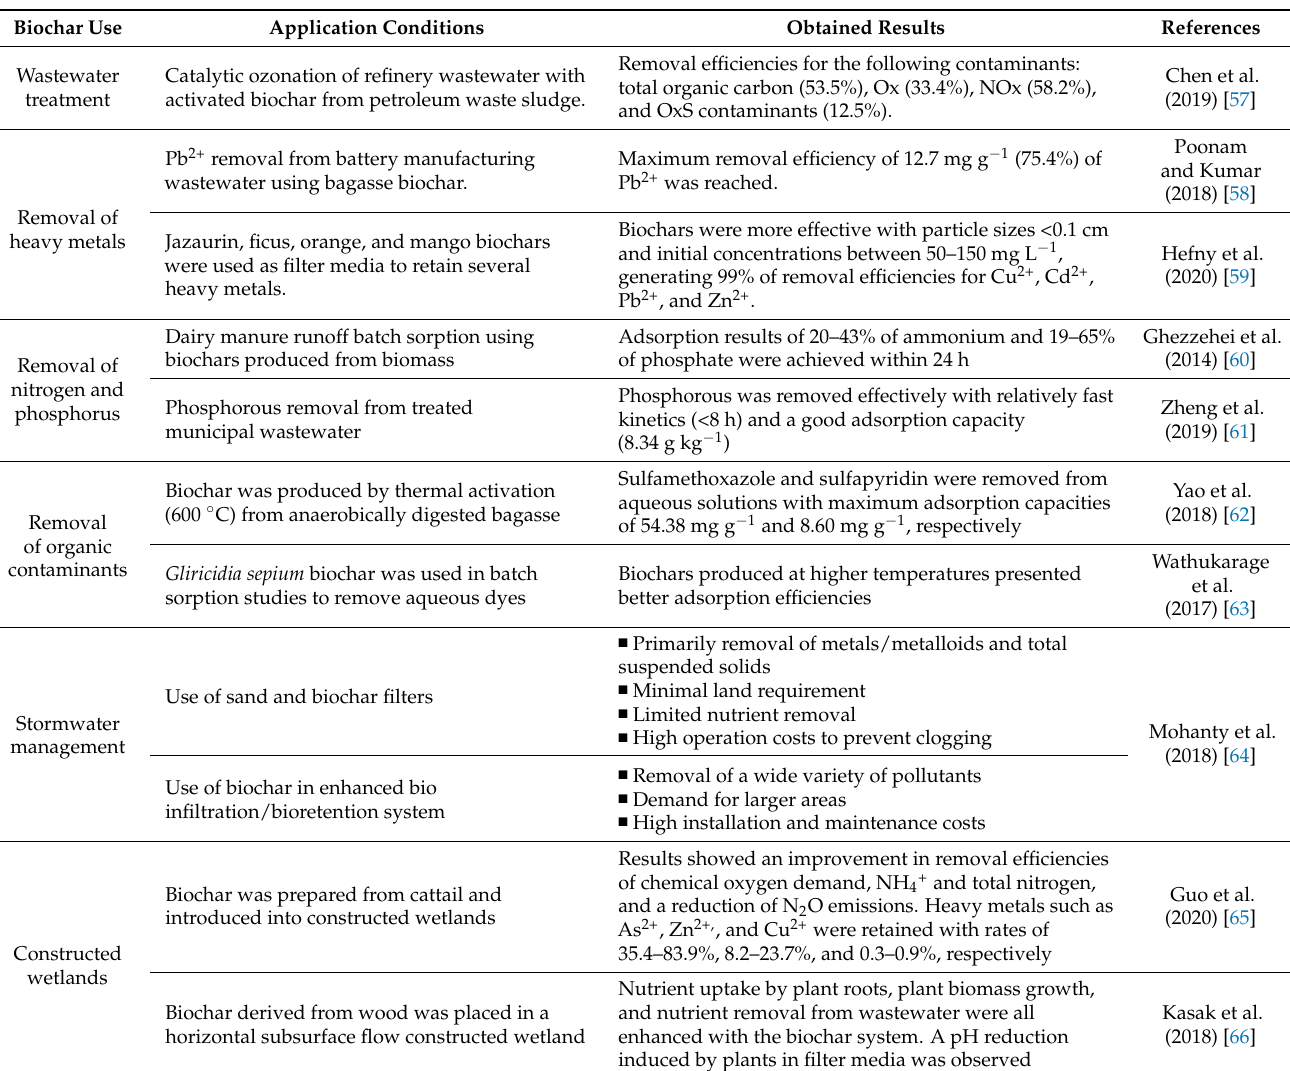
Table 5. List of studies focused on biochar applications for wastewater